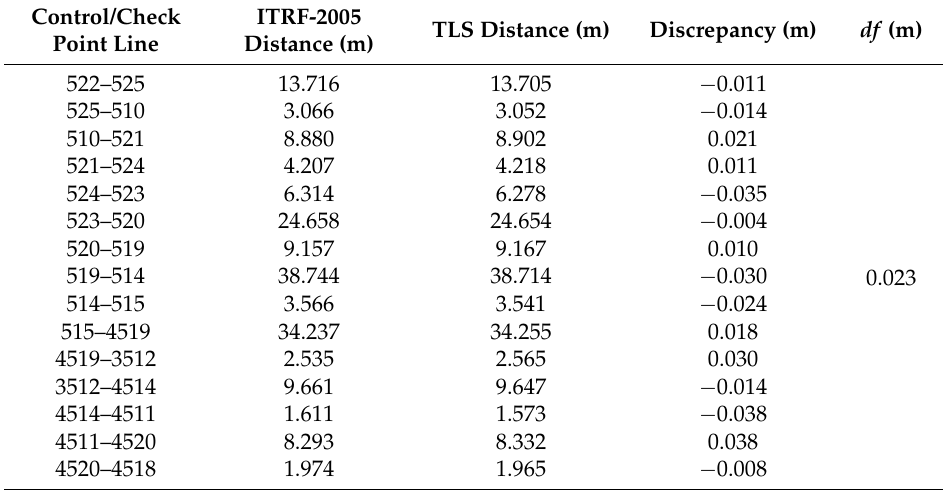
Table 2. The quality assessment criteria ( df ) for the outside 3-D point cloud model of the Mevlana Museum.